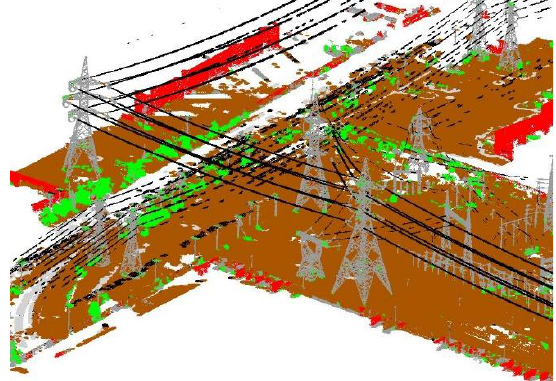
Figure 3. Location #3.1 after monosource semantic segmentation.